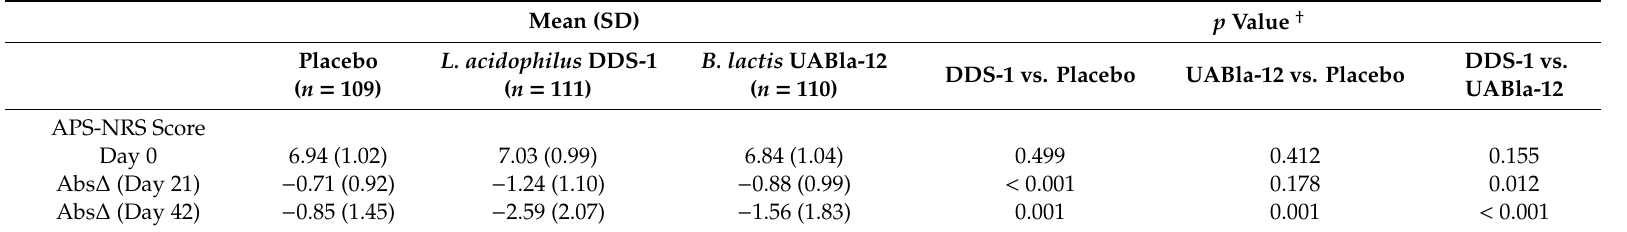
Table 2. Abdominal pain severity scores over the intervention